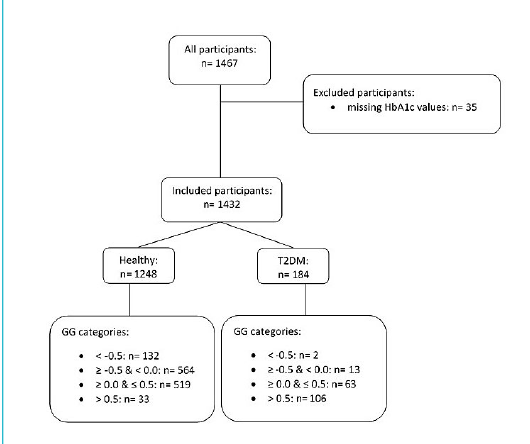
Figure 1: Chart representing all the recruited participants, with those retained and those excluded (n = number of participants). See text for primary exclusion criteria.GG = glycation gap; T2DM = type 2 diabetes